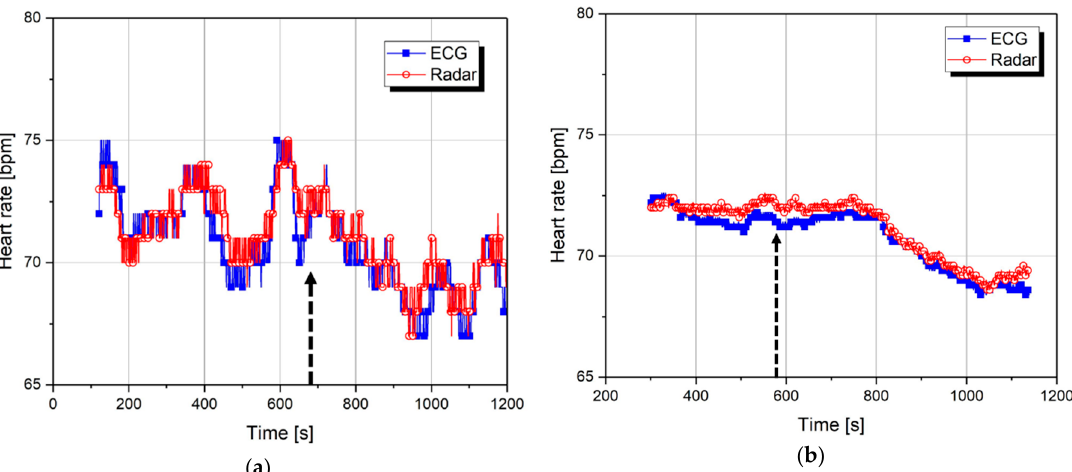
Figure 9. Variation of the heart rate for subject 5 in the wake–drowsiness states: ( a ) Using the window size of 60 s; ( b ) using the window size of 300 s.